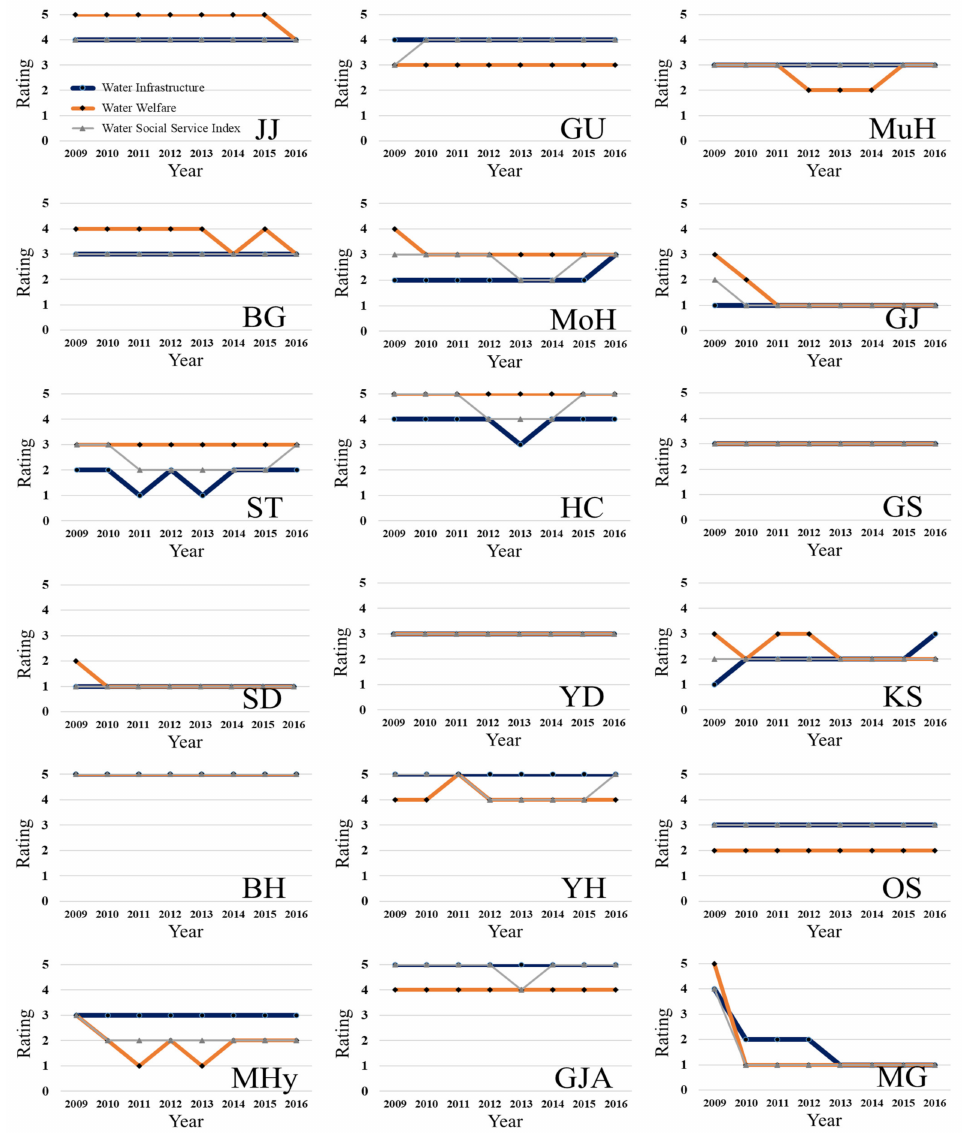
Figure 6. Annual rating variation in the index detailed indicators and WSSI (orange line) during the study